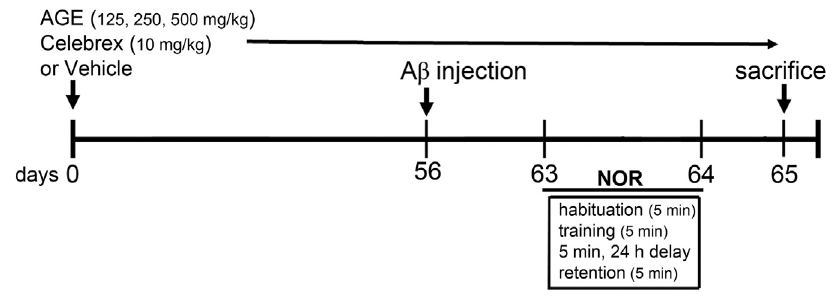
Figure 1. A schematic diagram of drug treatment and behavioral tests. Rats were injected with A β (1 ‐ 42) into both sides of lateral ventricle after 56 days of drug treatments (NOR: novel object recognition, A β : β‐ amyloid (1 ‐ 42)).